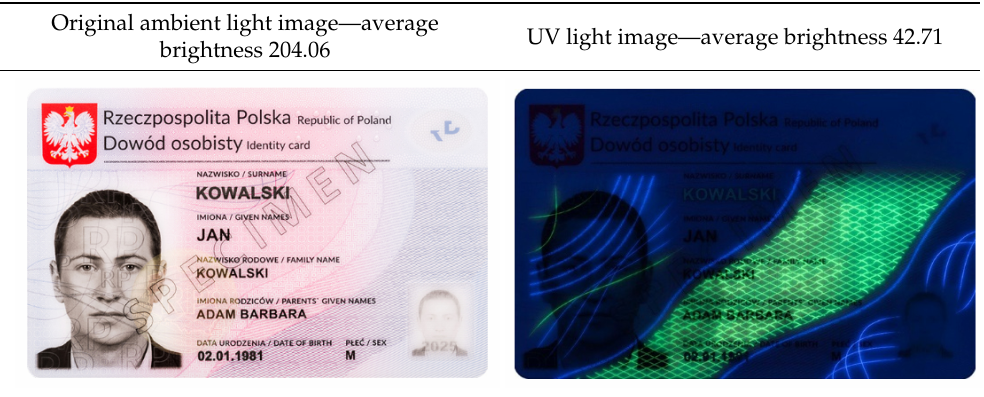
Table 2. Selected results of image processing simulation for 1%, 10%, and 100% of UV light image added to the ambient light image ( left ) and the expanded output images ( right ); average brightness of the differential image (not shown) and the output image is given in the right column (adapted from [3]). More images are provided in Supplementary